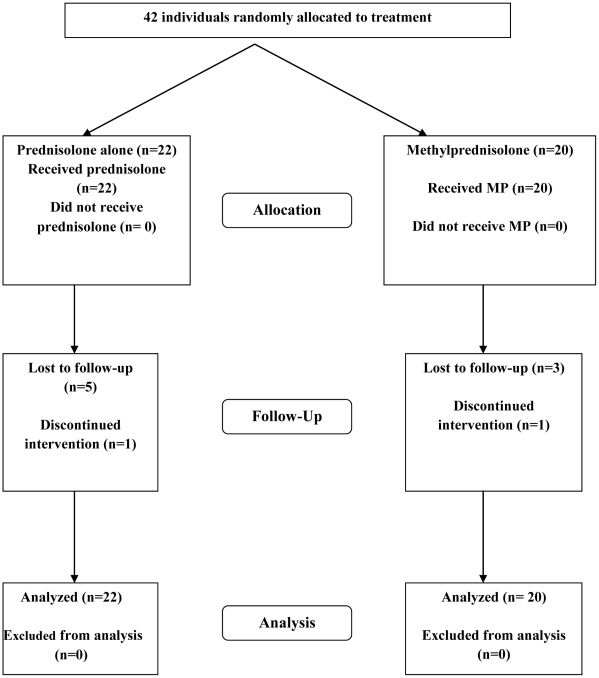
CONSORT flow diagram for the pilot study of individuals randomized to
either intravenous methylprednisolone and oral prednisolone or oral
prednisolone alone.